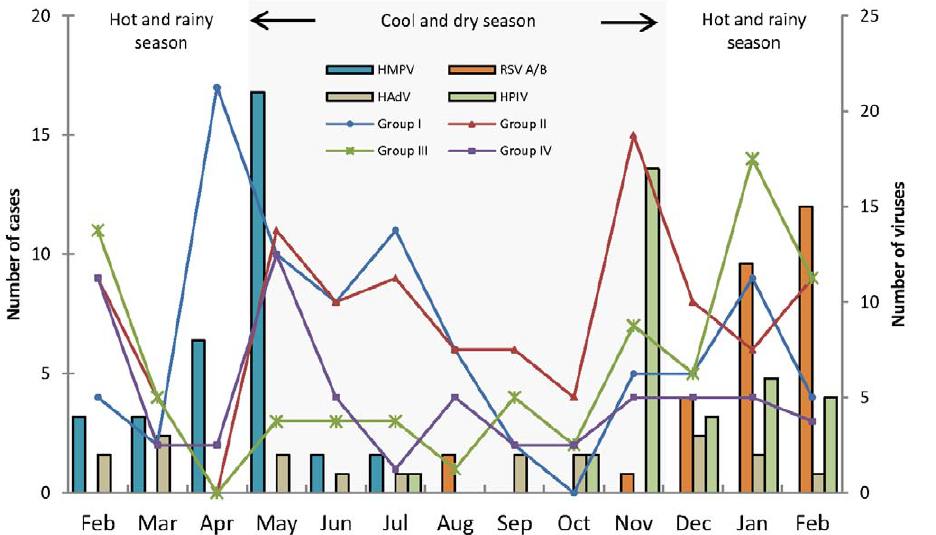
Figure 2. Seasonal distribution of acute respiratory infections in children, by type of the most frequently detected pathogens during one year. The number of cases collected in each defined clinical groups were represented on the left and the number of the viruses found were represented on the right. doi:10.1371/journal.pone.0043666.g002 PLOS ONE |